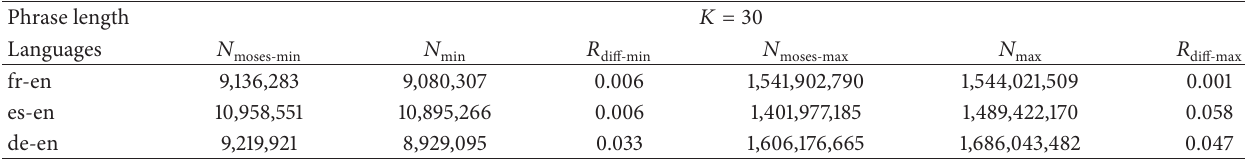
Table 10: Phrases comparison between Moses extraction and calculation result.